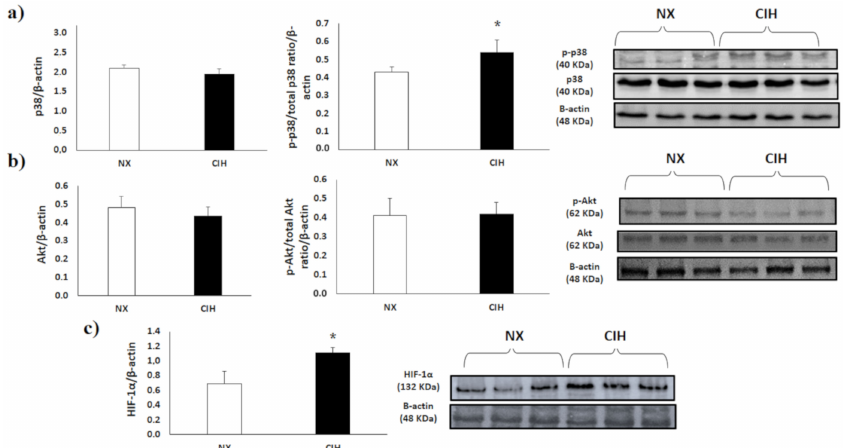
Figure 4. ( a ) Total p38 α expression and p38 α activity, assessed by the p-p38 α / p38 α ratio; ( b ) Total Akt expression and Akt activity assessed by the p-Akt / Akt ratio; ( c ) HIF-1 α expression in the right ventricle (RV), normoxia (NX; n = 10), chronic intermittent hypobaric hypoxia (CIH); n = 10. Protein levels were normalized to β -actin expression. Representative bands are shown. The values are the mean (x) ± standard error (SE). * p < 0.05: CIH vs. NX